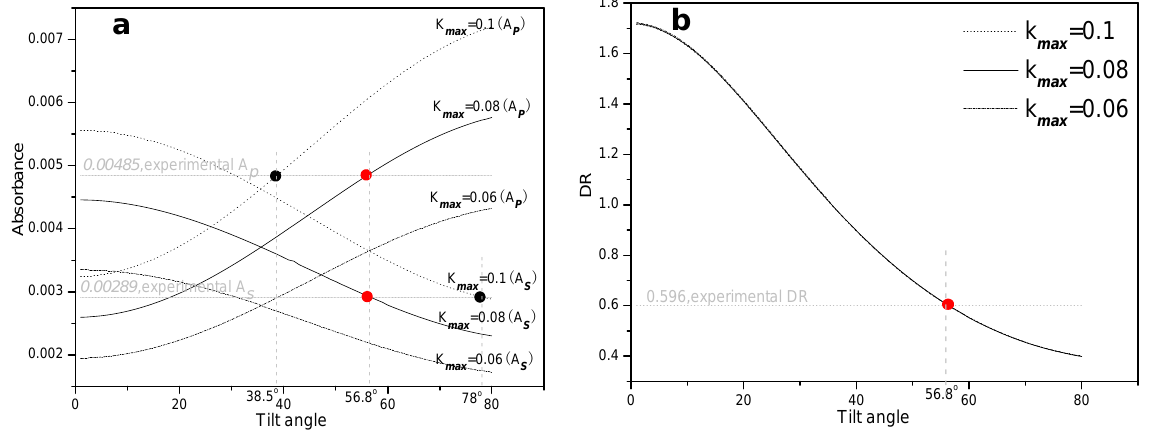
, A (a) and DR (b) against the tilt angle of egg PC SLBs Figure 5. The simulated A (s) (p) according to our previous method [31]. The experimental data were labeled as dots to obtain the right tilt angle of 56.8º. The parameters used for calculations are: 2923 cm -1 , 70º incidence, thickness of the bilayer = 5 nm, N = 10, n n = 1.0, and n = 2.018 + air Au